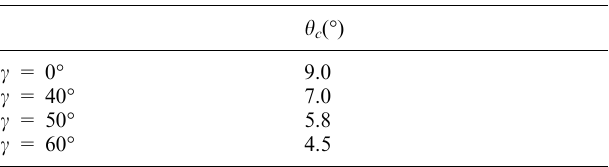
Table 3. Critical latitude values ( h c ) for c (cid:136) 0 (cid:14) , c (cid:136) 40 (cid:14) , c (cid:136) 50 (cid:14) and c (cid:136) 60 (cid:14) . T = 60 days.